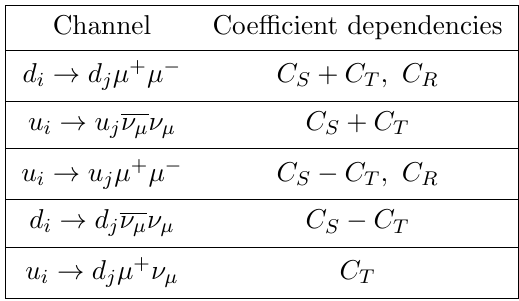
Table 3 . Dependencies of various semileptonic processes on the three coe(cid:14)cients C S;T;R (cf. eq. (1.4)). Here and in the text, a given quark level process represents all processes obtained through a crossing symmetry from the shown one.